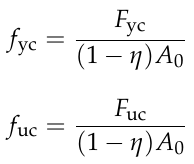
Table 4. The strength of tensile test.